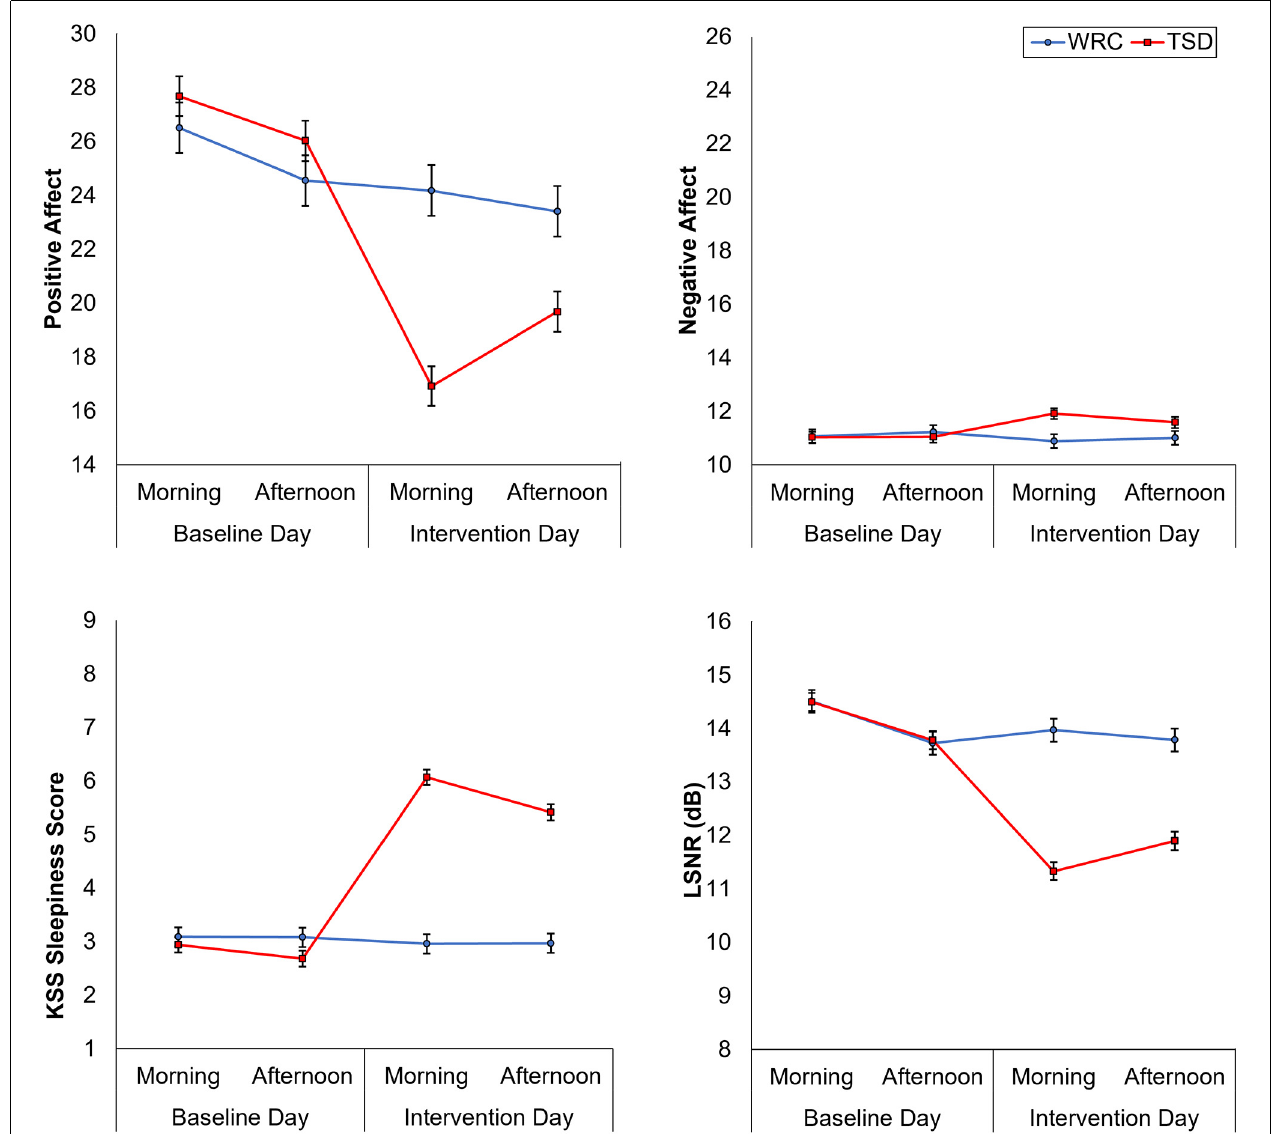
FIGURE 1 | Changes in positive and negative affect (top row), subjective sleepiness, and vigilant attention performance (bottom row), from the baseline day (morning and afternoon) to the intervention day (morning and afternoon). Error bars represent ± 1 standard error of the mean.